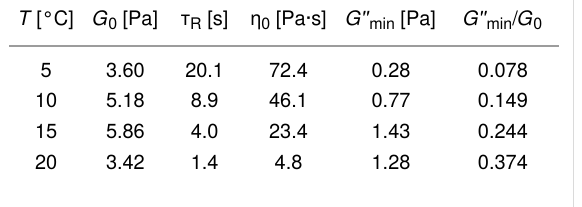
Table 2: Rheological values obtained from the oscillatory-shear experi- ments for the dirhamnolipid ethyl ester 2 /toluene (0.5 wt %) system at different